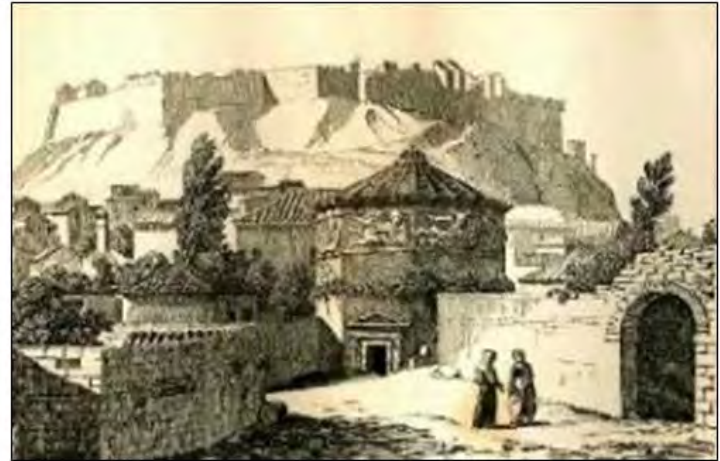
Figure 5. .Mevlevihan of Athens (Kus¸, 2011)